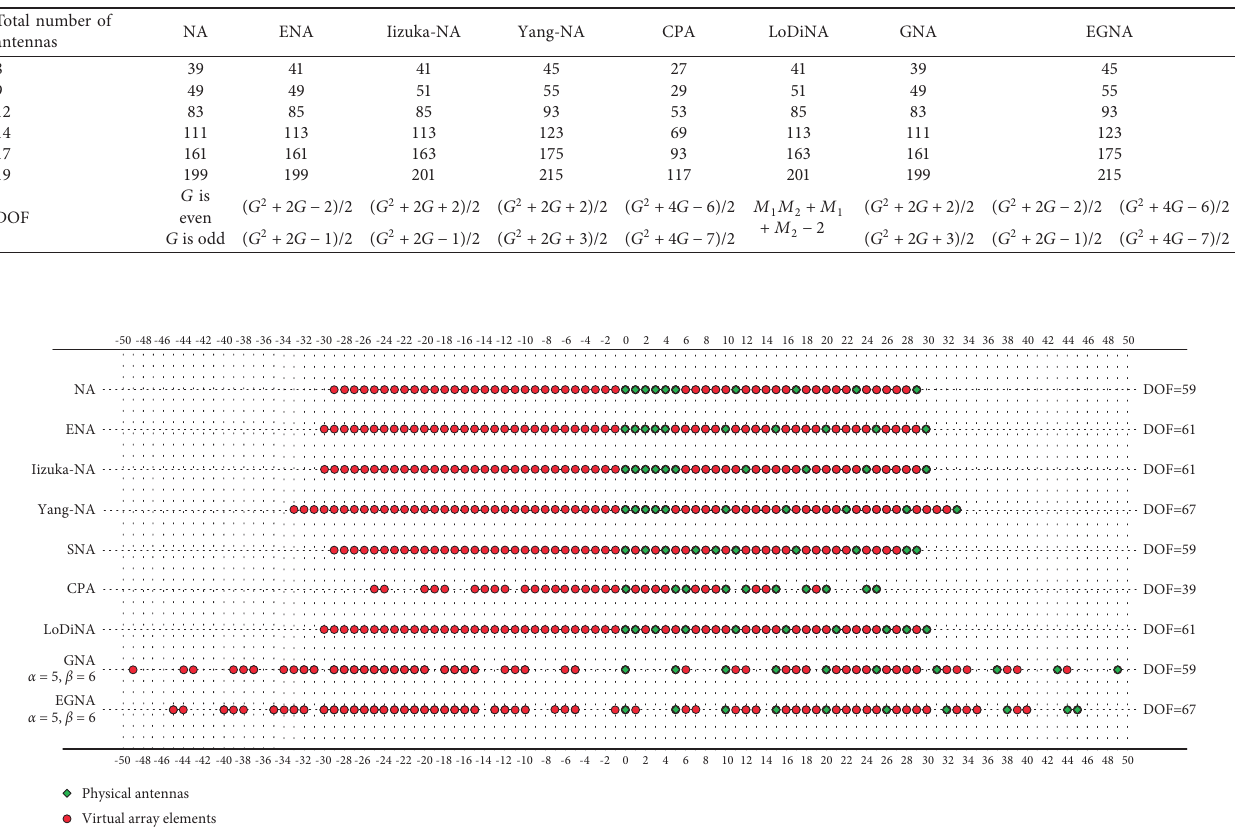
Table 2: Comparison of DOF for different arrays.